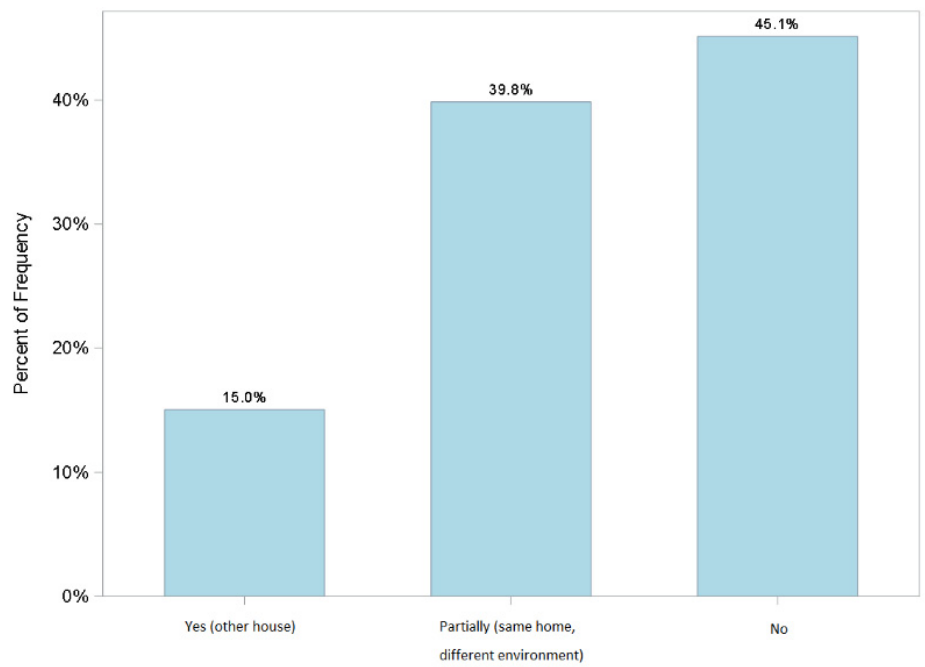
Figure 4. Q25. I returned to normal daily habits because I felt sufficiently reassured by the implementation of the corporate organizational model.